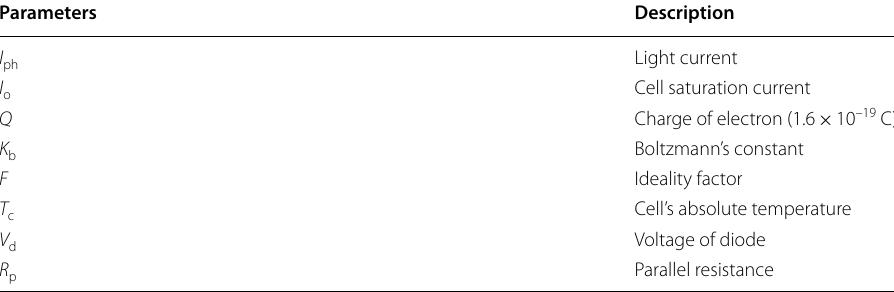
Table 1 Description of the parameters used in Eq. (1) Parameters